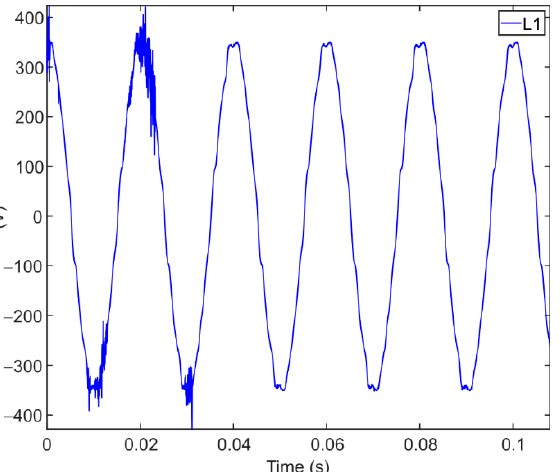
Figure 7. Waveform with complex disturbances: harmonics and oscillations.